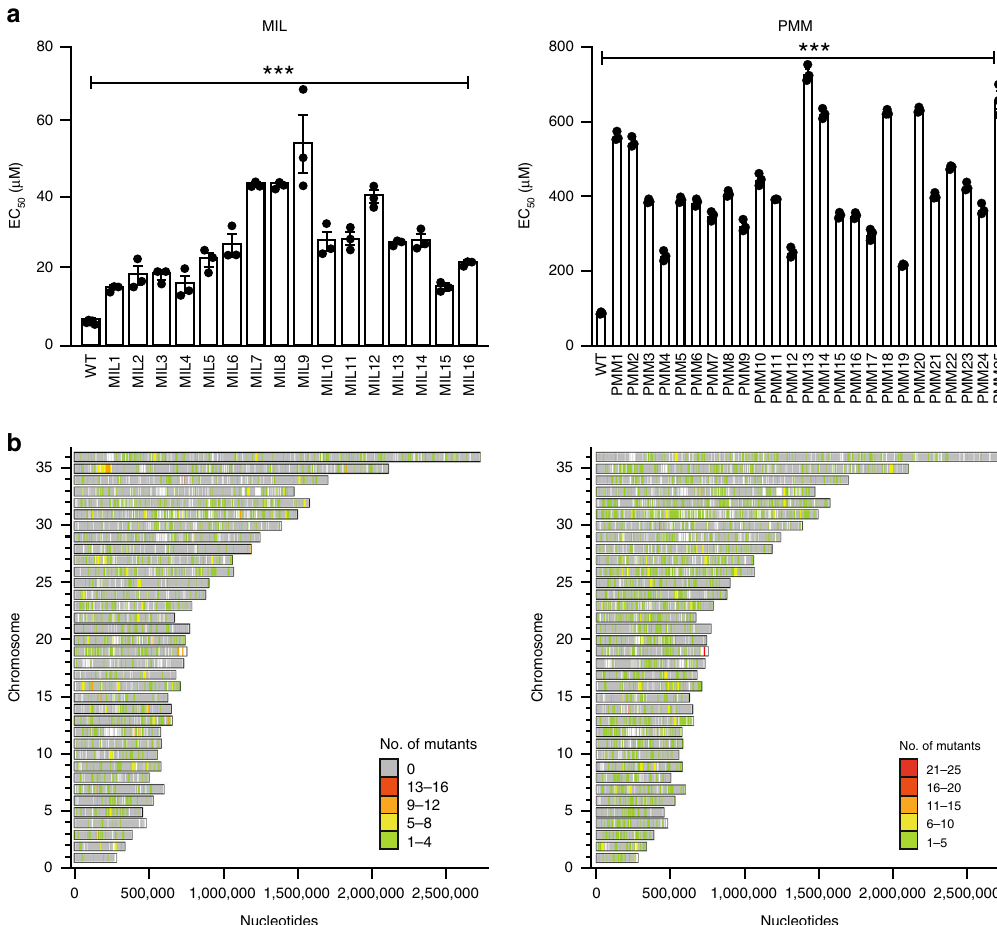
Fig. 1 Drug susceptibility and mutations in Leishmania selected for resistance. a Susceptibility to miltefosine (MIL; left panel) and paromomycin (PMM; right panel) were performed on individual clones. The wild-type L. infantum (WT) is shown for both drugs. The MIL resistant mutants were selected after mutagenesis with either EMS or HMPA (Supplementary Table 1) while the PMM-resistant mutants were selected after mutagenesis with EMS, ENU, or MMS (Supplementary Table 1). Data are mean ± SEM. For the MIL susceptibility assay, n = 5 biologically independent replicates for the wild-type and n = 3 biologically independent replicates for the mutants. For the PMM susceptibility assay, n = 3 biologically independent replicates. Statistical analyses were performed using unpaired two-tailed t -tests. *** P < 0.001. b Genome-wide distribution of SNVs in mutants selected against MIL (left panel) and PMM (right panel). Bars represent the genes on each chromosome. Colored bars represent genes mutated in de fi ned numbers of mutant clones; gray bars represent non-mutated genes. Source data are provided as a Source Data fi